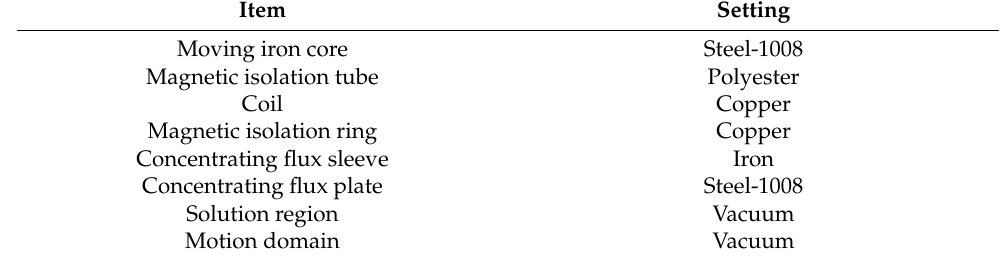
Table 1. Part material setting.